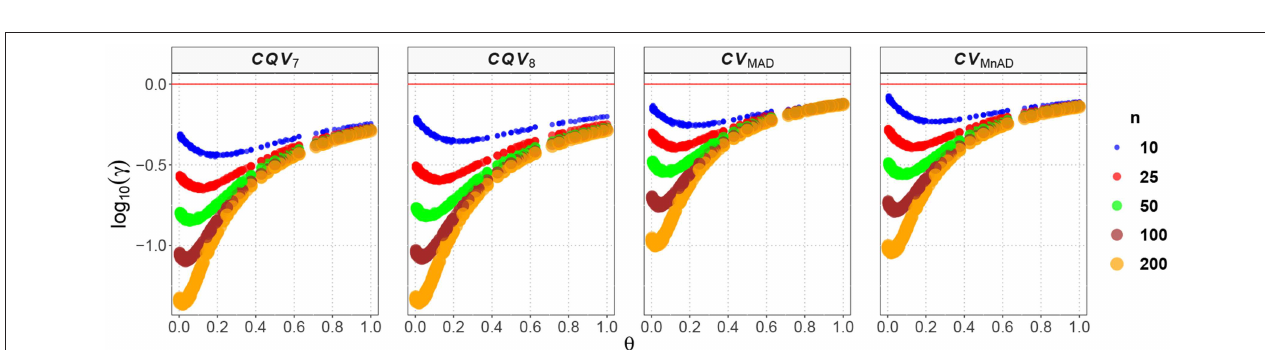
(0,1) produced for each estimator and sample size under the ∈